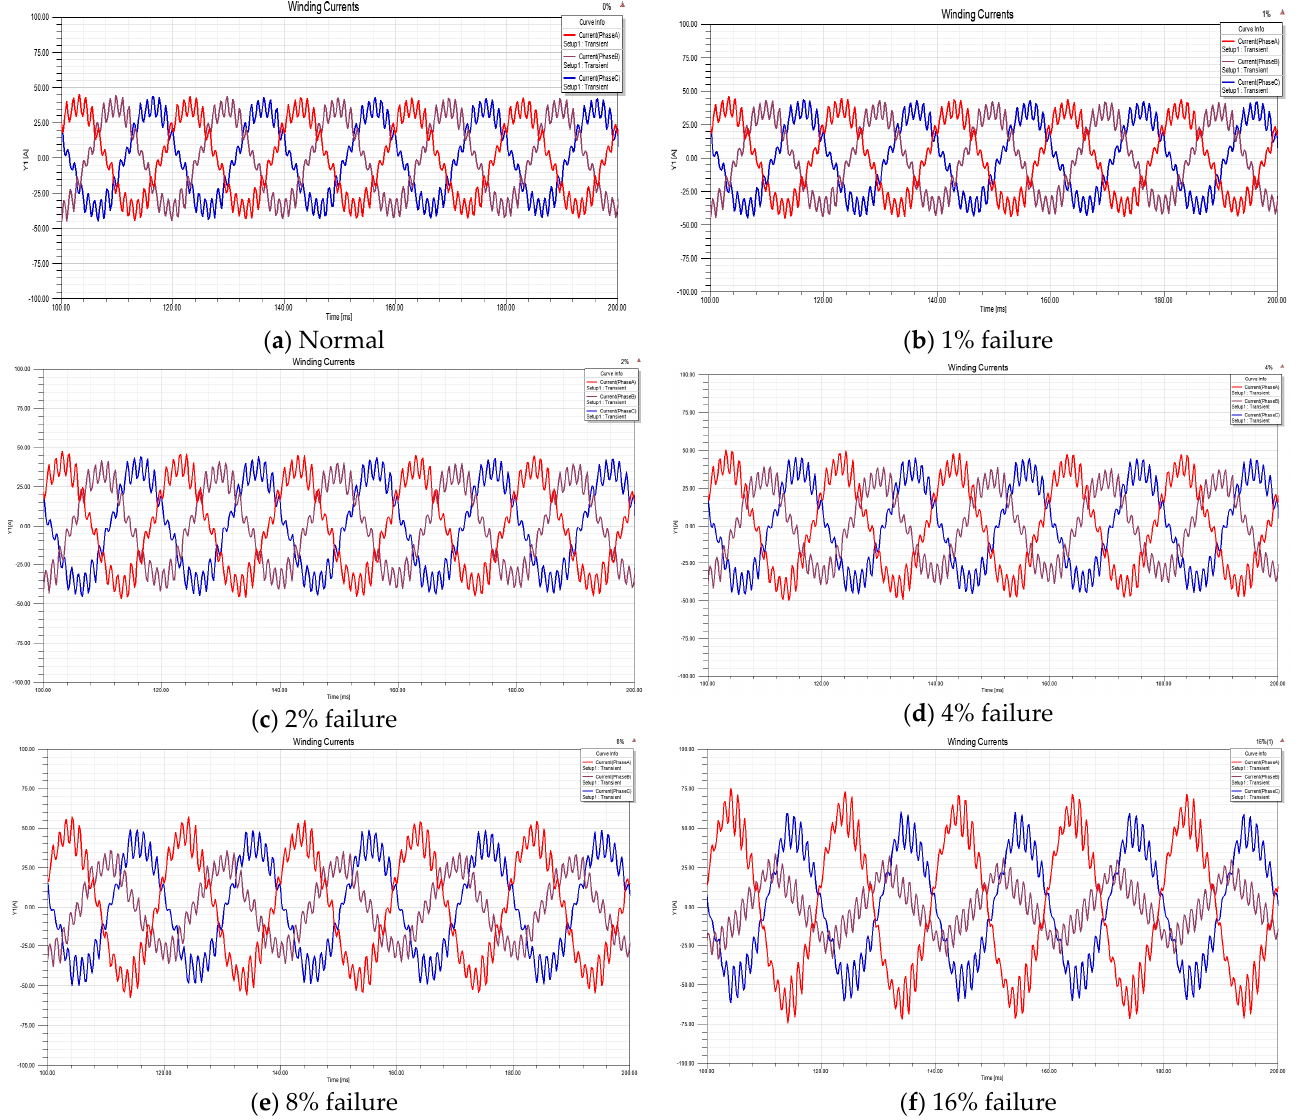
Figure 3. Three − phase Current Curve of Motor under Different Conditions.